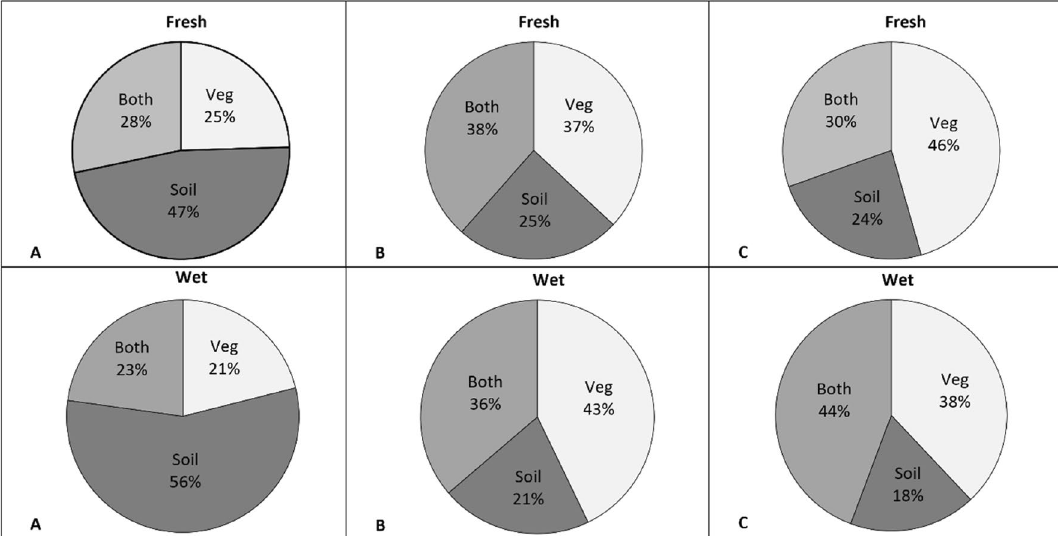
Figure 4. Percentage of the number of taxa occurring in soil seed bank and vegetation cover in the fresh and the wet meadow. ( A ) Invasion zone; ( B ) transition zone; ( C ) control zone; Veg participation of taxa